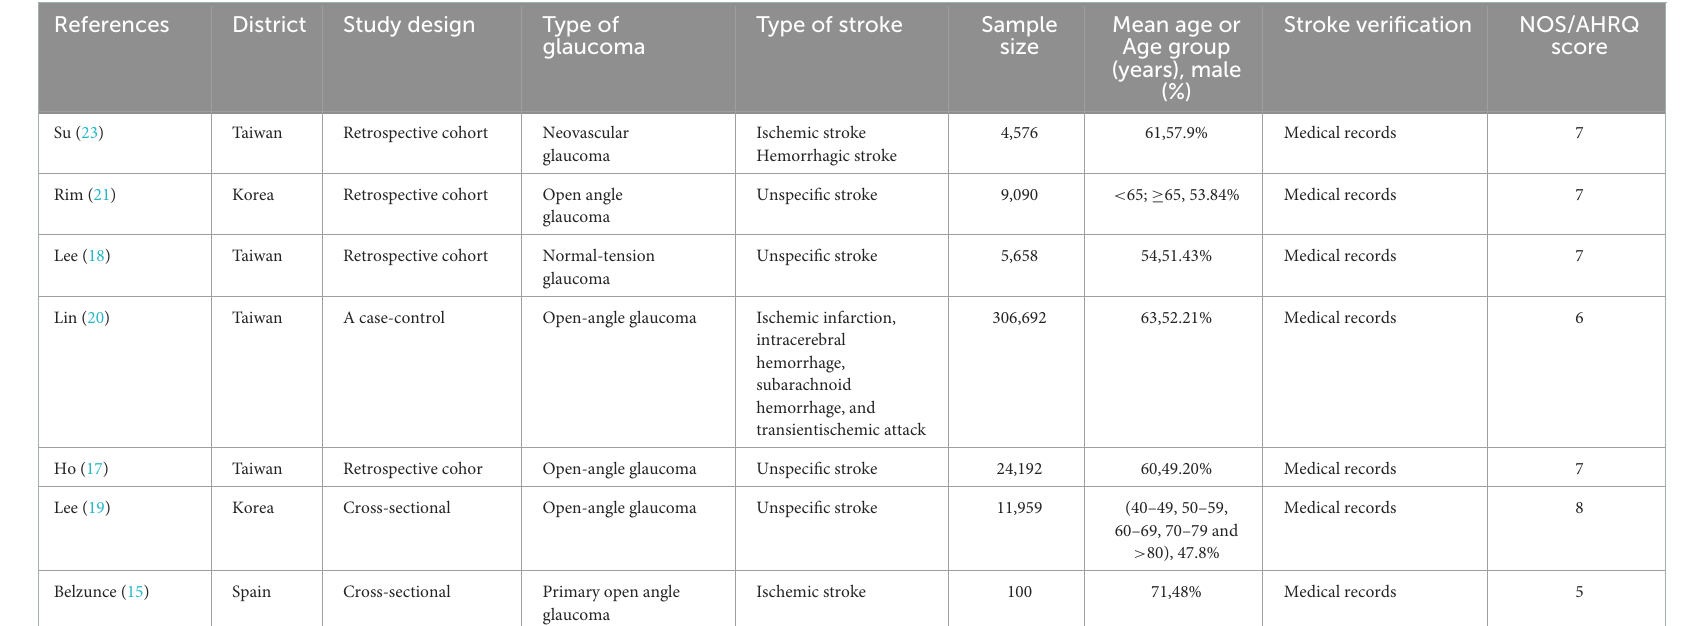
TABLE 1 Main characteristics of included